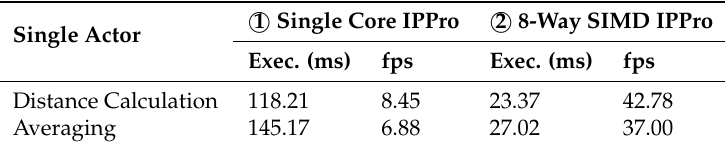
Table 7. Performance measurements for designs 1 (cid:13) and 2 (cid:13) highlighted in Figure 11.